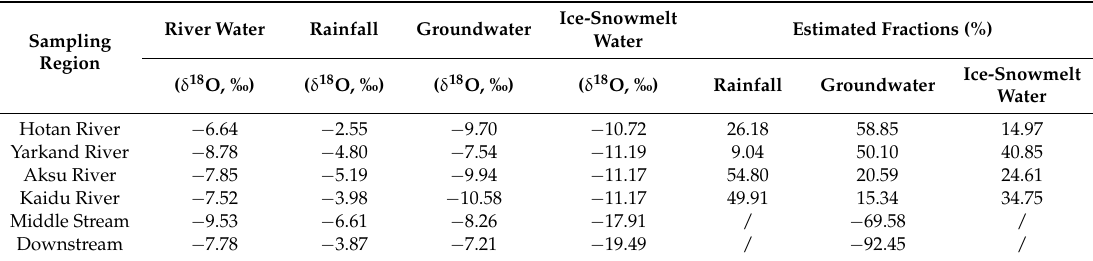
Table 2. The mean concentration of tracers in different water types and the fraction of water sources discharged to river